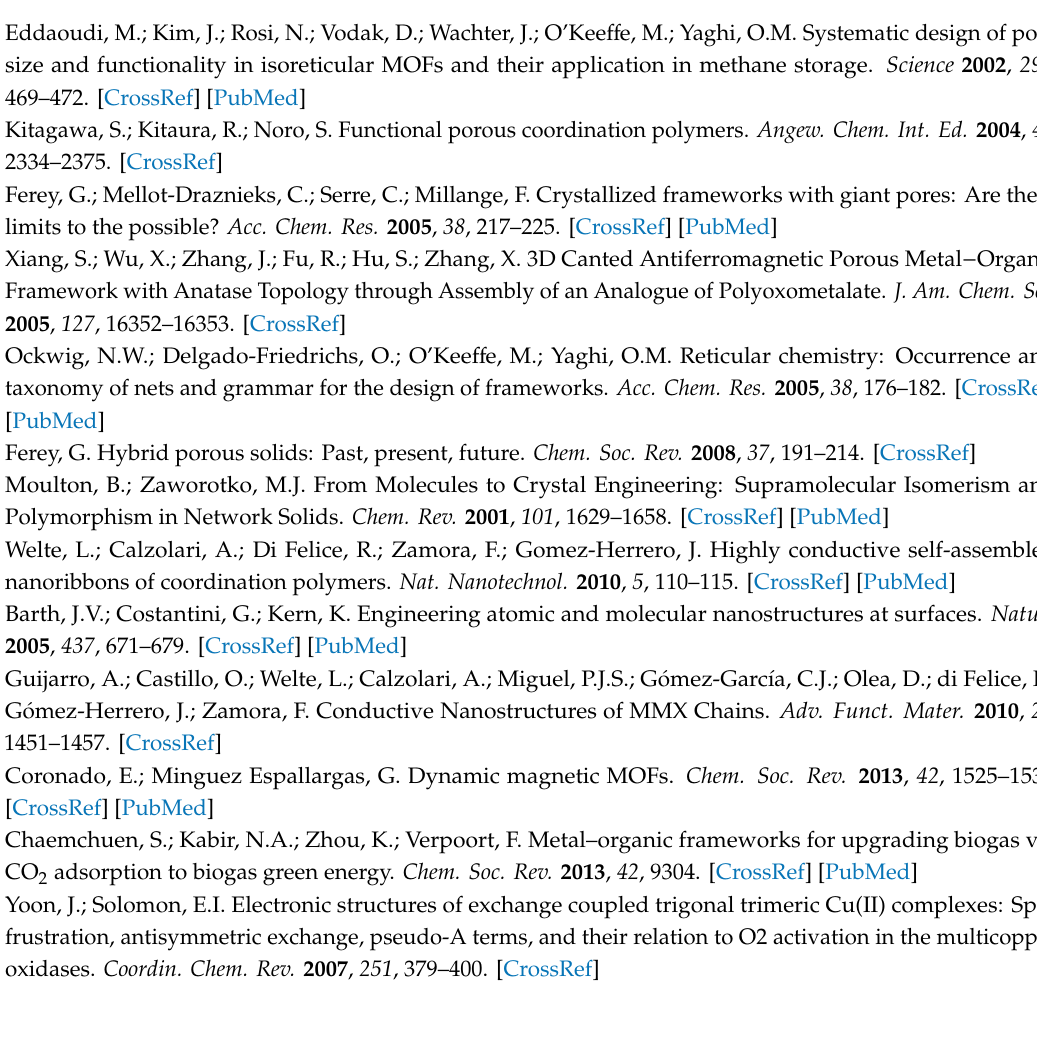
Figure S1: Simulated PXRD pattern (blue) and experimental PXRD pattern (red) of 1 , Figure S2: (a) Simulated PXRD pattern (blue) and experimental PXRD pattern (red) of 2 ; (b) experimental PXRD patterns of 2 synthesized by method A (blue) and method B (red), Figure S3: Thermogravimetric (TG) analysis diagrams of 1 and 2, Figure S4: (a) The two-fold interpenetrated network of 2 ; (b) the 1D channels along the a axis of 2 , Figure S5: Plot of χ M − 1 (cycle) vs. temperature for a microcrystalline sample of compound 1 . The solid line represents the best fit χ M − 1 above 50 K with a Curie–Weiss law, Figure S6: Plot of χ M − 1 (cycle) vs. temperature for a microcrystalline sample of compound 2 . The solid line represents the best fit χ M − 1 above 50 K with a Curie–Weiss law, Figure S7: Field dependence of magnetizations of compound 2 at 2.0